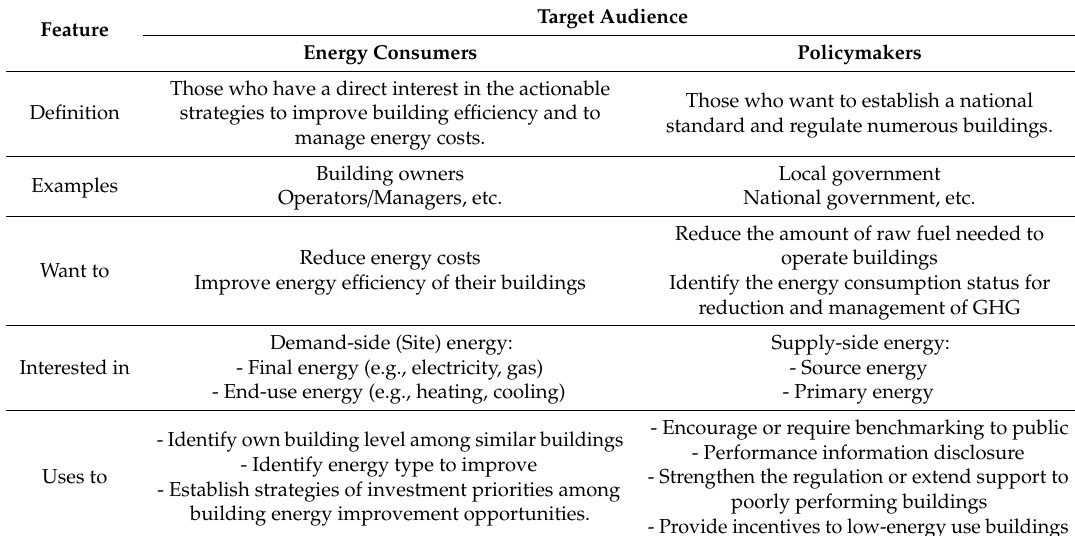
Table 1. Purpose and requirements of energy benchmarking according to target